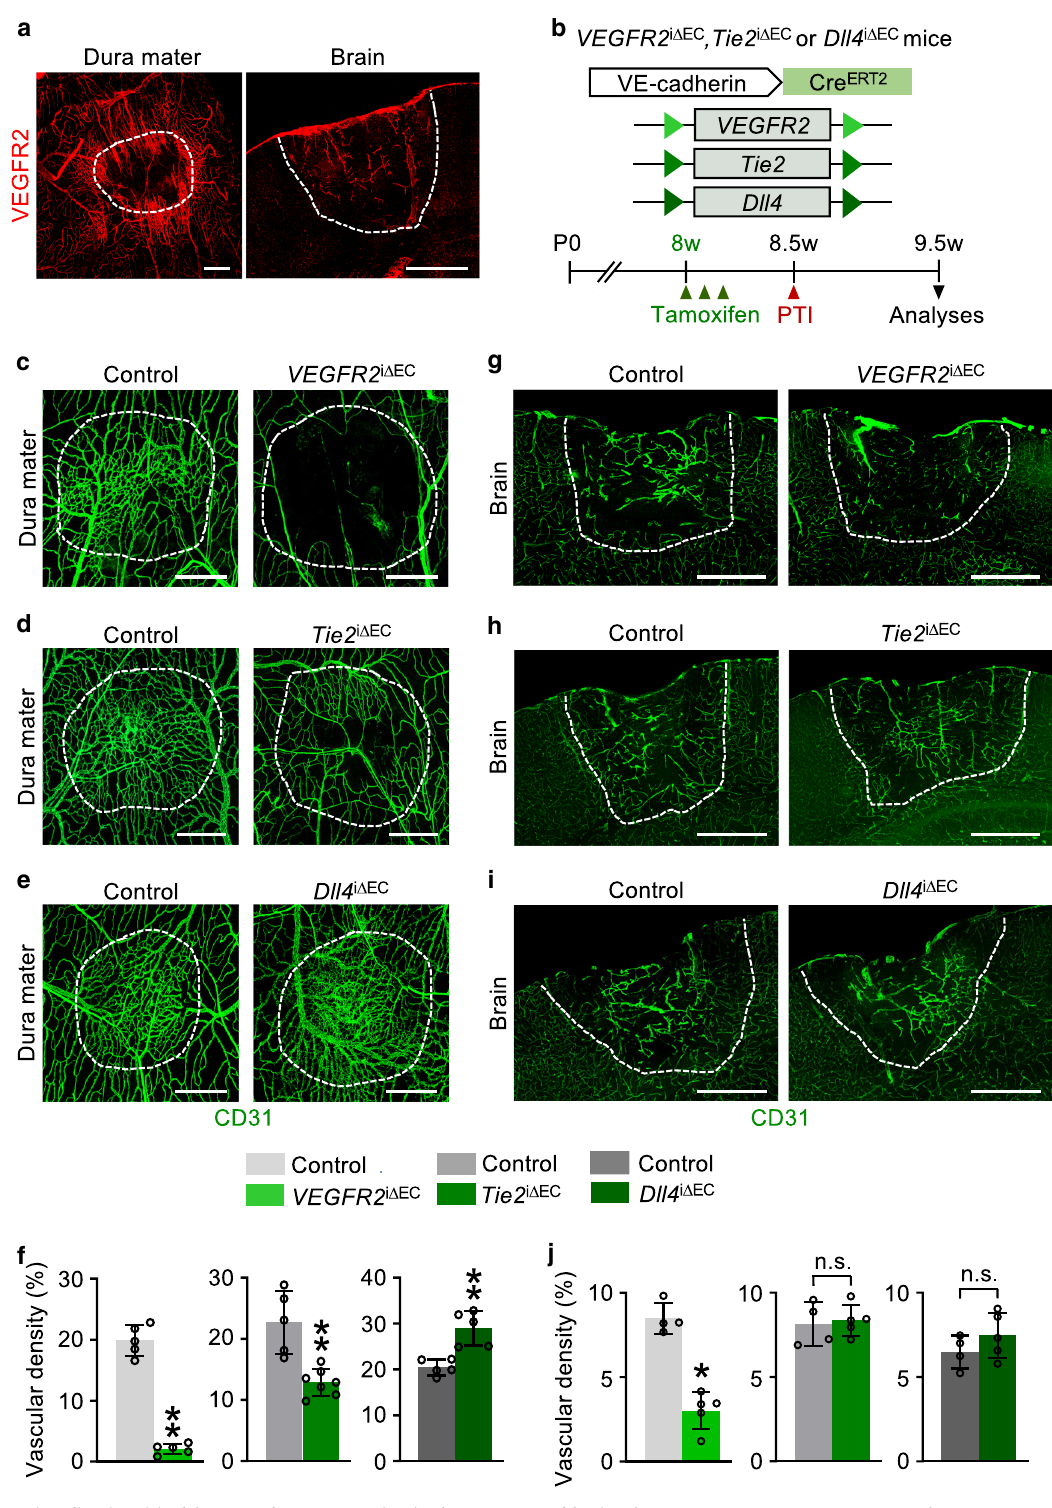
Fig. 2 VEGFR2 signaling is critical for vascular regeneration in dura mater and brain after PTI. a Representative images of VEGFR2 upregulation in the surrounding BVs of putative injury areas (white dotted-lined circle or line) at D3 in adult mice. Similar fi ndings were observed in four mice from two independent experiments. Scale bars, 500 µ m. b Diagram depicting generation of VEGFR2 i Δ EC , Tie2 i Δ EC , or Dll4 i Δ EC mice and EC-speci fi c deletion of VEGFR2 , Tie2 , or Dll4 in 8-week-old mice by i.p. injections of tamoxifen, PTI, and their analyses at 1 week after PTI. c – j Representative images and comparisons of CD31 + BVs of putative injury areas (white dotted-lined circle or line) in the dura mater and brain at D7 in control and VEGFR2 i Δ EC , Tie2 i Δ EC , or Dll4 i Δ EC mice. Scale bars, 500 µ m. Each dot indicates a value from one mouse and n = 7 (Dura mater Tie2 i Δ EC ), n = 4 (Brain controls), n = 5 (all other groups) mice/group from two independent experiments. Vertical bars indicate mean ± SD. * P < 0.05, ** P < 0.01 versus control by two-tailed Mann – Whitney U